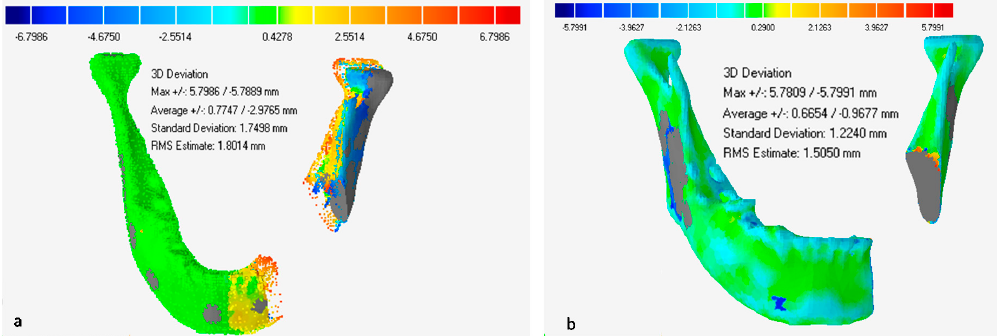
Figure 12. Three-dimensional (3D) inspection results of the resected original mandible model with ( a ) mirror reconstruction model and ( b ) cavity-filled reconstruction model.